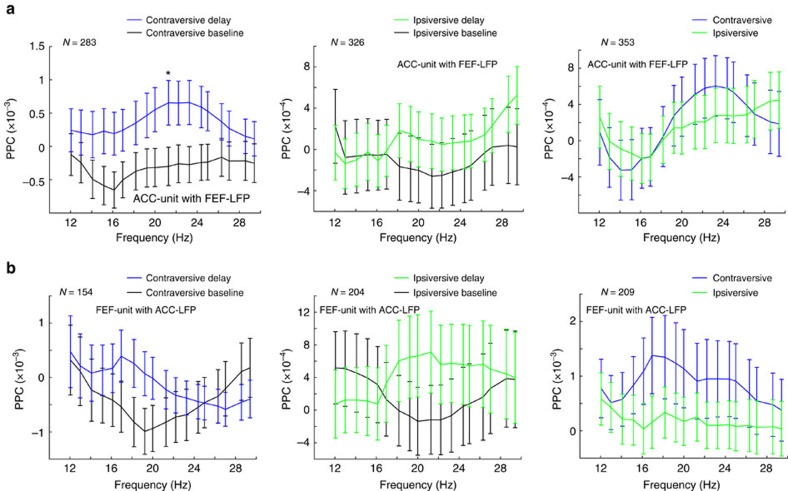
Pairwise phase consistencies (PPCs) across beta band.(a) PPC spike-field coherence spectrum of the population of the ACC-unit with FEF-LFP pairs across the beta frequency range. Comparison between baseline and delay of contraversive saccades (left), comparison between baseline and delay of ipsiversive saccades (middle), and comparison between the contra- and ipsi-versive saccades in the delay period (right). (b) PPC spike-field coherence spectrum of the population of the FEF-unit with ACC-LFP pairs across the beta frequency range. Comparison between baseline and delay of contraversive saccades (left), comparison between baseline and delay of ipsiversive saccades (middle), and comparison between the contra- and ipsiversive saccades in the delay period (right). Error bars denote s.e.m. in all panels. *P<0.05, paired t-test.